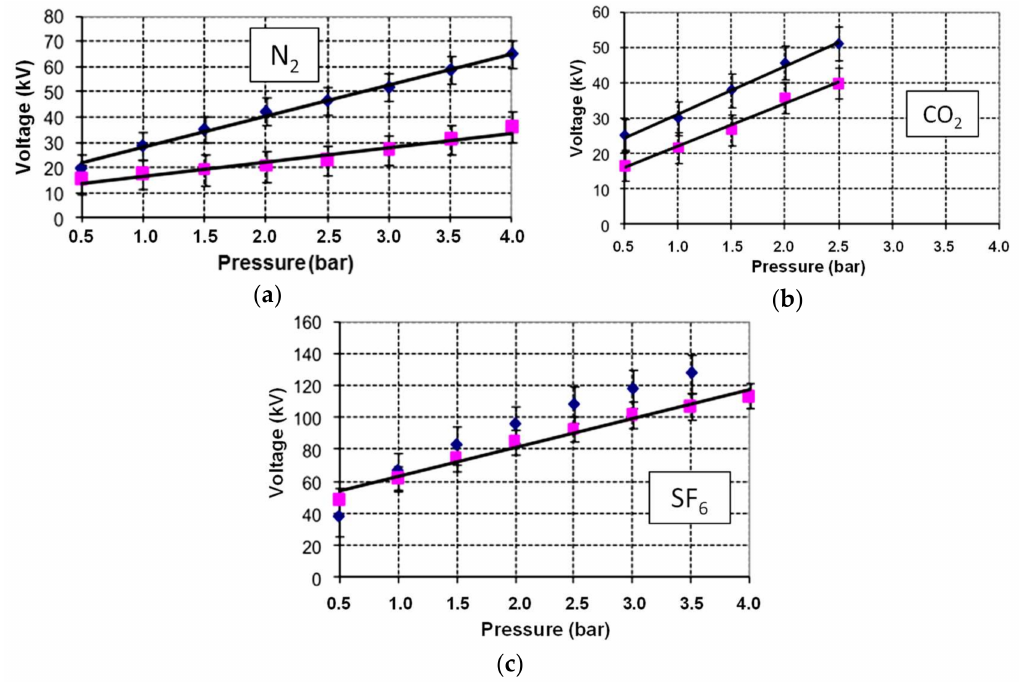
Figure 6. Comparison of breakdown voltages of N 2 ( a ), CO 2 ( b ) and SF 6 ( c ) gases in positive ( ) and negative ( ) DC in point–plane electrode arrangement; electrode gap = 10 mm.